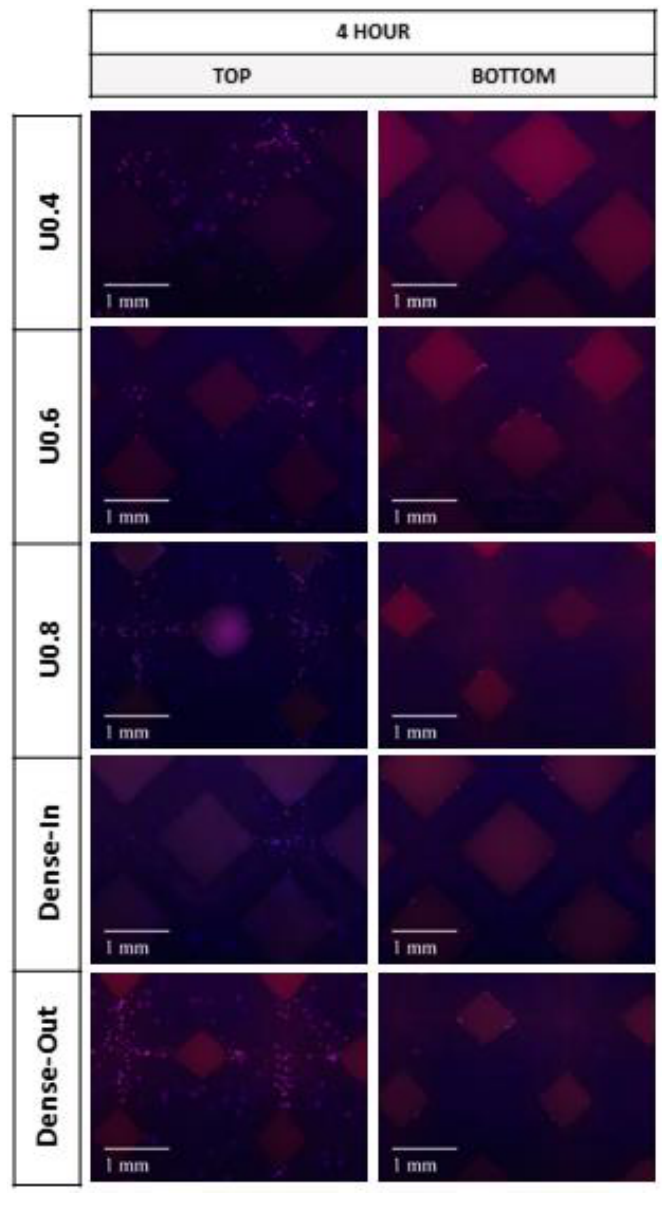
Figure 9. Fluorescence micrographs representing merged Hoechst stained nucleus (blue) and actin cytoskeleton (red) of MC3T3-E1 preosteoblast cells on the uniform and gradient BCC structures after culturing for 4 h. Top represents the side where cells were seeded onto the samples.